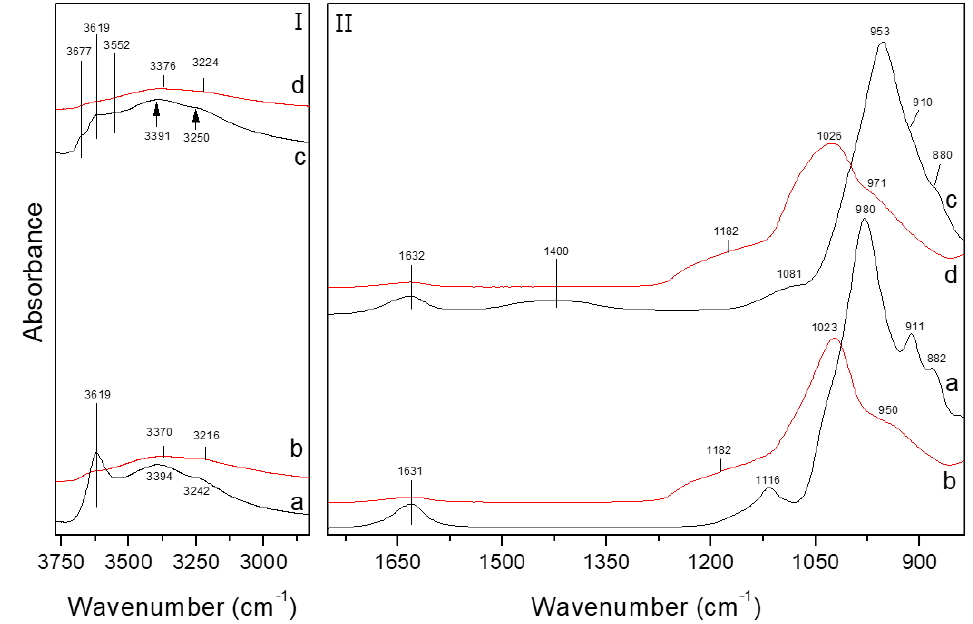
Figure 5. FT-IR spectra of the starting montmorillonite ( a ), mont-PCH ( b ), starting saponite ( c ) and sap-PCH ( d ).